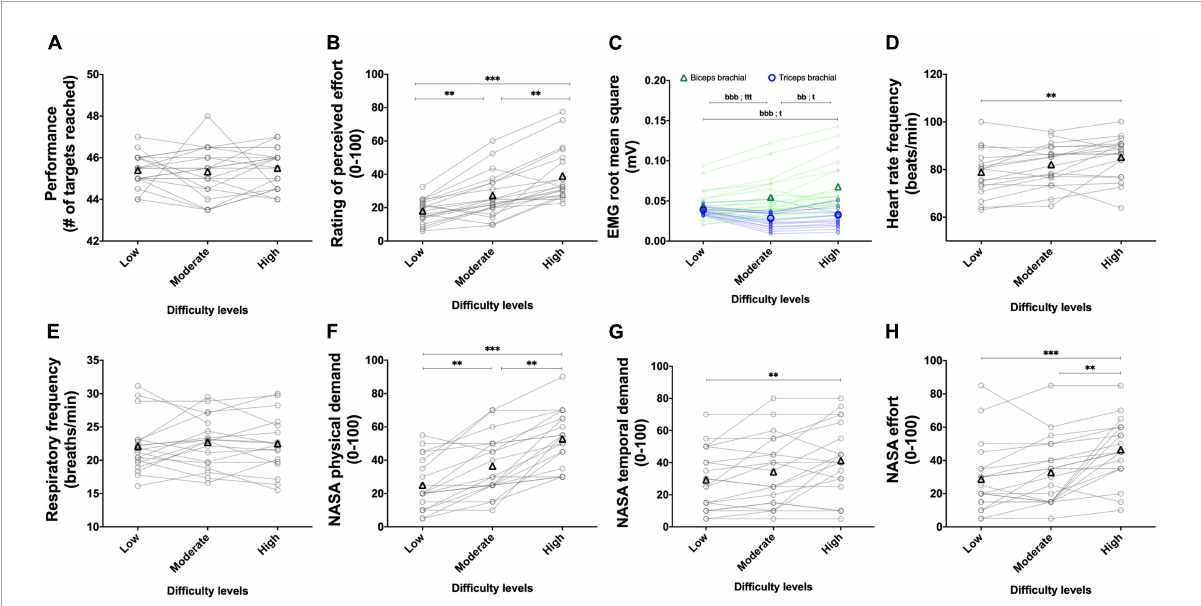
FIGURE8 Experiment 1B: Adding weight on the forearm to alter task difficulty during the pointing task. Effect of manipulating the weight during the pointing Task on performance ( A , n = 20), rating of perceived effort ( B , n = 20), EMG root mean square of the biceps (green line) and triceps (blue line) brachial muscles ( C , n = 20), heart rate frequency ( D , n = 17), respiratory frequency ( E , n = 20) and NASA TLX scores for the physical demand ( F , n = 20), the temporal demand ( G , n = 20) and the subjective effort ( H , n = 20). Movements were performed at a fixed tempo of 1.5 Hz. For the low difficulty, no additional weight on the forearm was added. For the moderate difficulty, a weight of 0.5 kg was added. For the high difficulty, a weight of 1 kg was added. Data are presented as the main effect of difficulty, except for panel (C) presenting the difficulty × muscle interaction. The n indicates the number of participants with all the data in each of the three levels of difficulties. Changes in the n reflect data loss due to the equipment. Individual data are presented in gray circles and means in black triangles. *Main effect of difficulty, the difference between two difficulty levels. b and t difference between two difficulty levels for the biceps and triceps brachial muscles, respectively. One symbol: p < 0.05, two symbols: p < 0.01, and three symbols: p < 0.001.